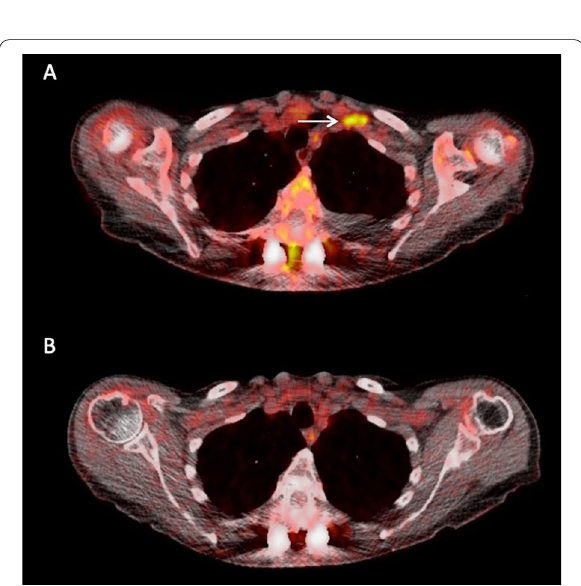
Fig. 3 Transaxial PET/CT images at the thoracic level of a 69‑year‑old female MM patient before and after therapy. A Baseline PET/CT demonstrated a hypermetabolic, intramuscular, soft‑tissue lesion in the thoracic wall with no relationship to the bone (arrow) as a sign of EMD. B Follow‑up PET/CT showed a complete metabolic remission of the EMD as response to treatment ( B )